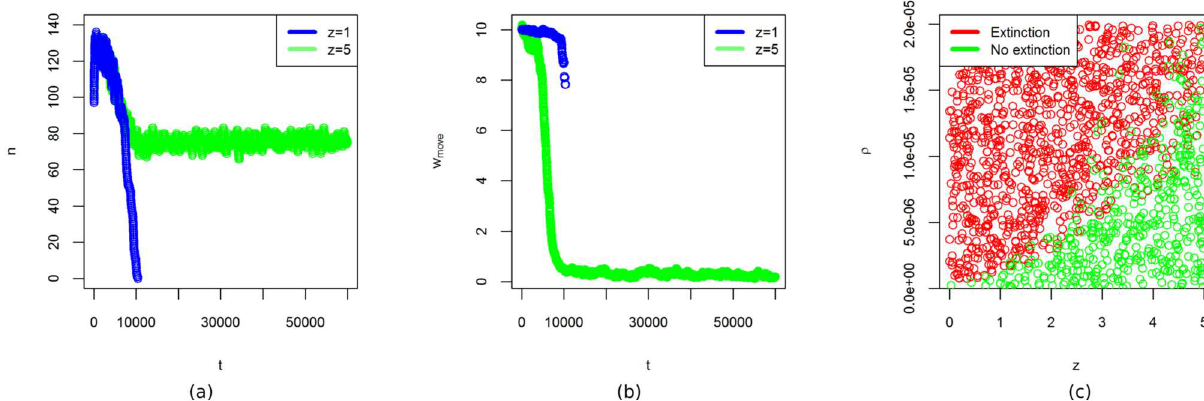
Fig 12. Increasing pressureover time. (a): Number of agents n as function of time for a rate of adaptation z = 1 (blue) and z = 5 (green). In both plots ρ = 5 × 10 − 5 Eq (10). (b): Average value of w move across agents, for the same model runs as in (a). (c): Each point in the figure correspondsto a run of 60,000 time-steps. Red points indicate that the populationhas gone extinct, whereasfor the green points the populationhas remained positive until the end of the simulation. Extinction occurs if the rate of adaptation z is insufficientto cope with the pressure increase ρ